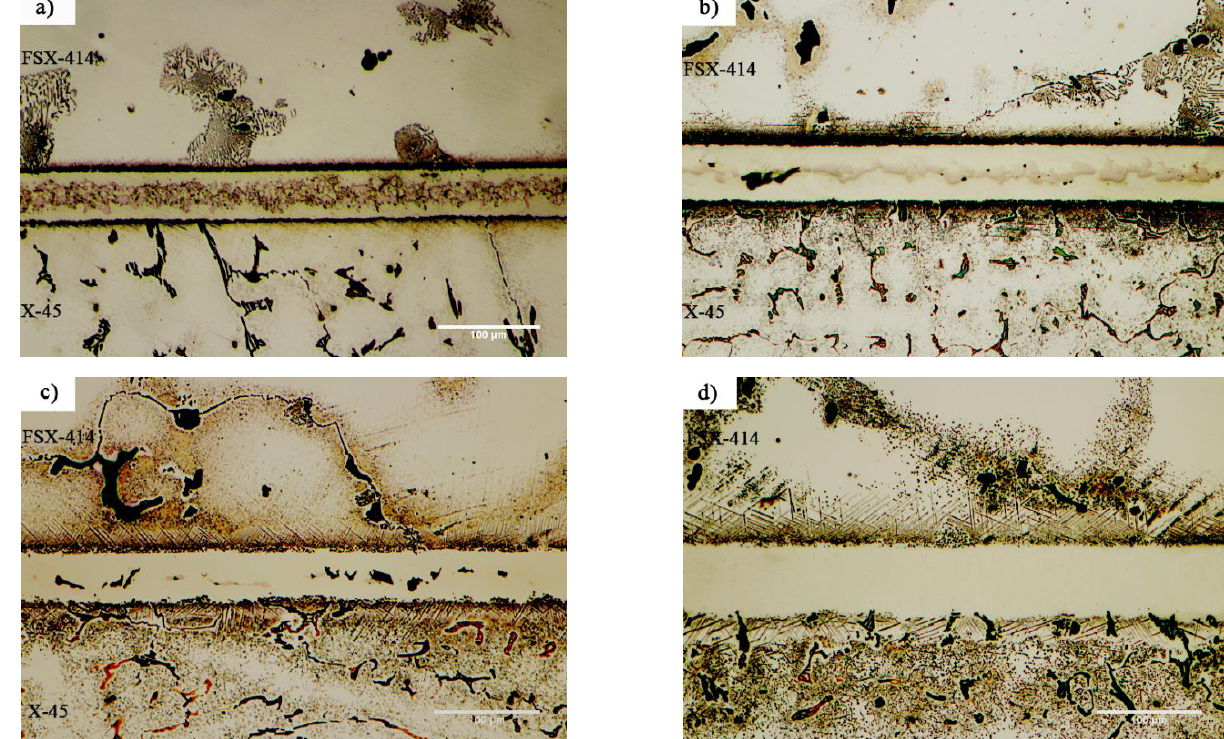
Figure 7. Optical microscopy of microstructural evolution of vacuum brazed at constant holding times of 10 min at different temperatures: ( a ) 1010 °C, ( b ) 1050 °C, ( c ) 1100 °C, and ( d ) 1150 °C.